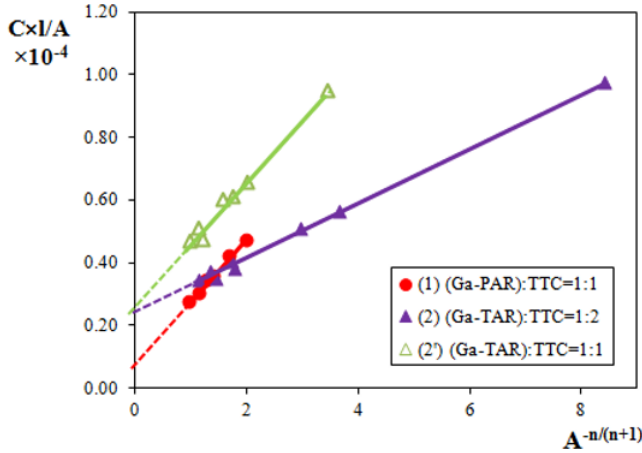
Figure 6. Determination of the constants of association ( β ) and true molar absorptivities ( ε ) by the method of Komar-Tolmachev. pH=6.5, C =2×10 -4 mol L -1 (straight line 1); PAR pH=6.7, C =2.2×10 -4 mol L -1 (straight lines 2 and 2’). TAR The following stright lines (Y=aX+b) slopes (a) and Y-intercepts (b) were obtained: (1) a=(1.985±0.050)×10 -5 , b=(8.73±0.72)×10 -6 ; (2) a=(8.722±0.014)×10 -6 , b=(2.424±0.051)×10 -5 ; (2’) a=(1.975±0.072)×10 -5 , b=(2.67±0.15)×10 -5 . The calculated true molar absorptivities ( ε =1/b) are ε =(1.14±0.09)×10 5 , ε =(4.13±0.09)×10 4 and ε =(3.7±0.2)×10 4 L mol -1 cm -1 respectively. Table 5. Molar absorptivities of some binary and ternary gallium(III)